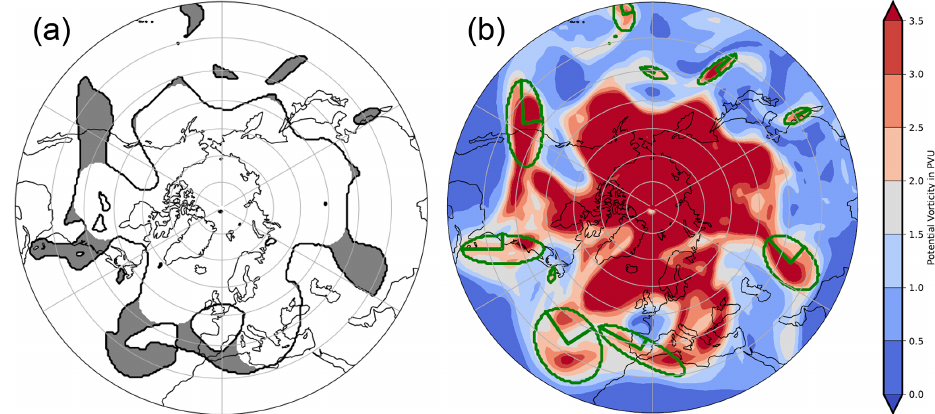
Figure 6. A 200–500hPa layer-averaged PV based on the S2S prediction database (Vitart et al., 2017) initialized and valid on 7 May 1998, 00:00 UTC. (a) PVSs identified using the default configuration without filtering the results; (b) filtered PVSs using a length threshold of 1000km, approximated by best-fit ellipses, with raw PV values shaded in the background. Ellipses are defined by their computed main